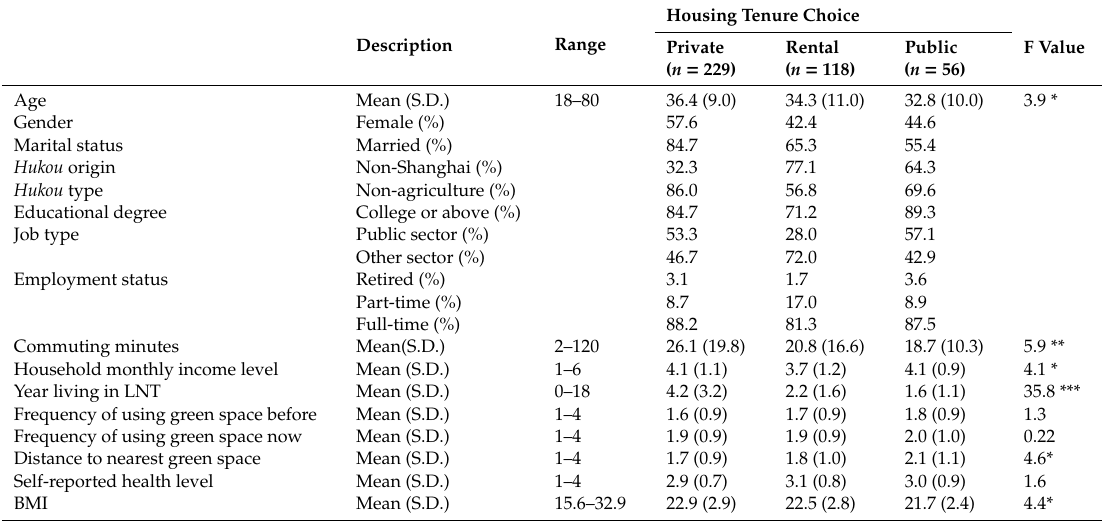
Table 1. Summary statistics (by housing tenure